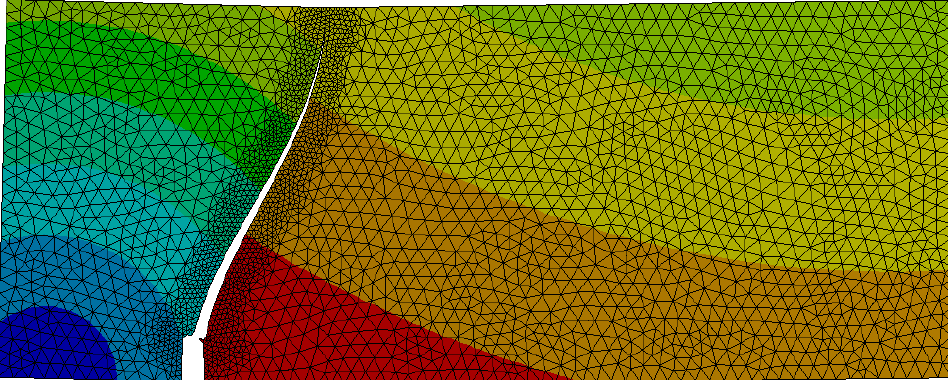
Figure 12. Equivalent Von-Mises stress distribution for specimen 3.